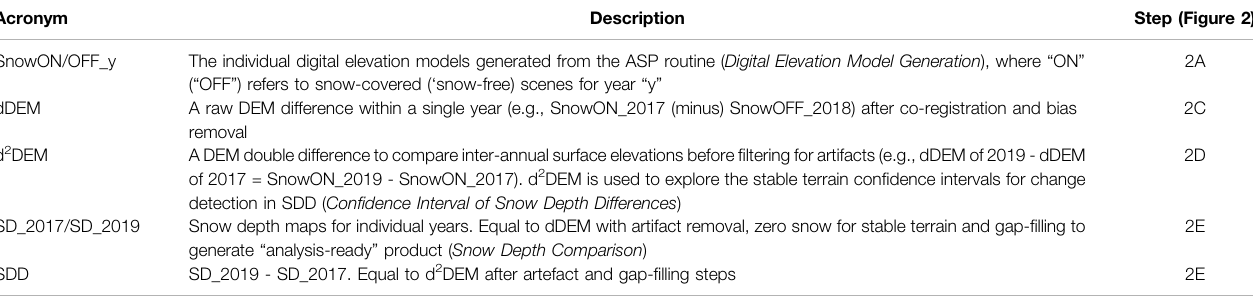
TABLE 2 | Key acronyms to describe elevation models or elevation model differencing to calculate snow depth of inter-annual snow depth differences in this